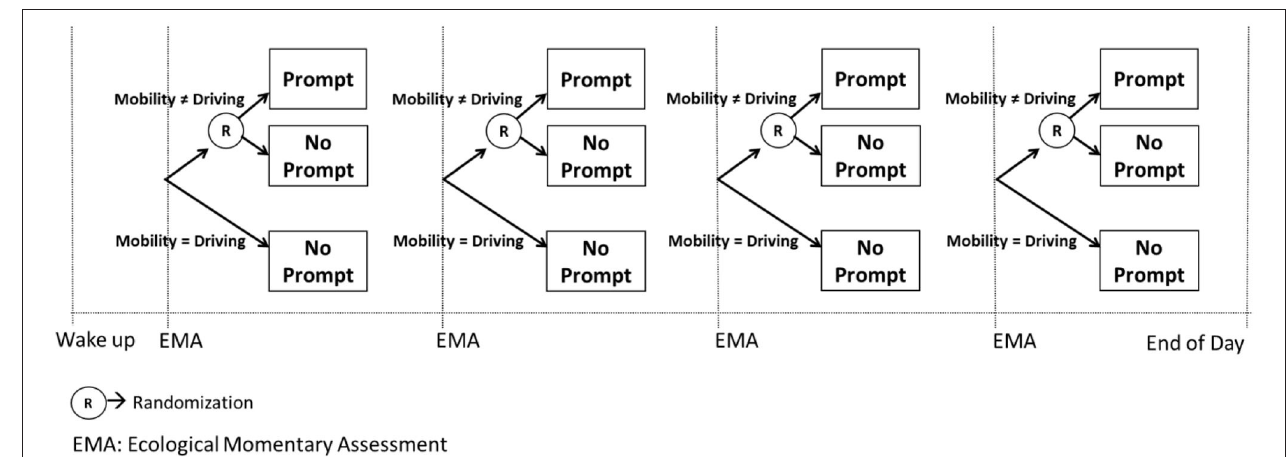
FIGURE 5 | A MRT to answer Example E scientific